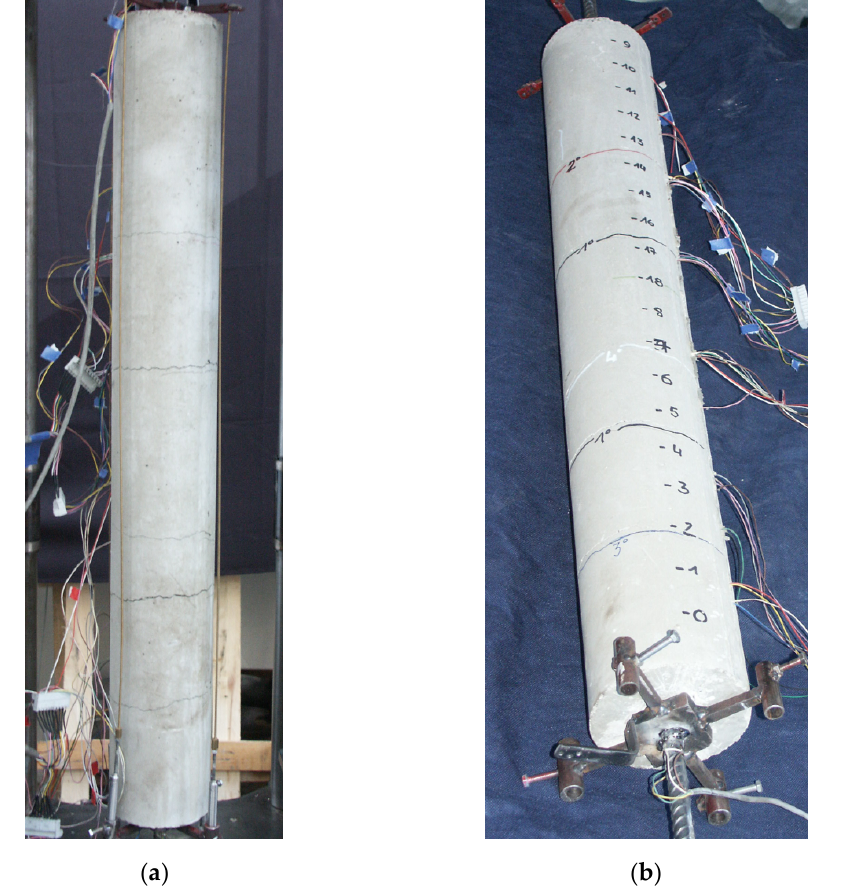
Figure 15. Reinforced concrete specimen no.5 tested at the Laboratory of the University of Pisa: ( a ) specimen during the test, ( b ) specimen after the test.